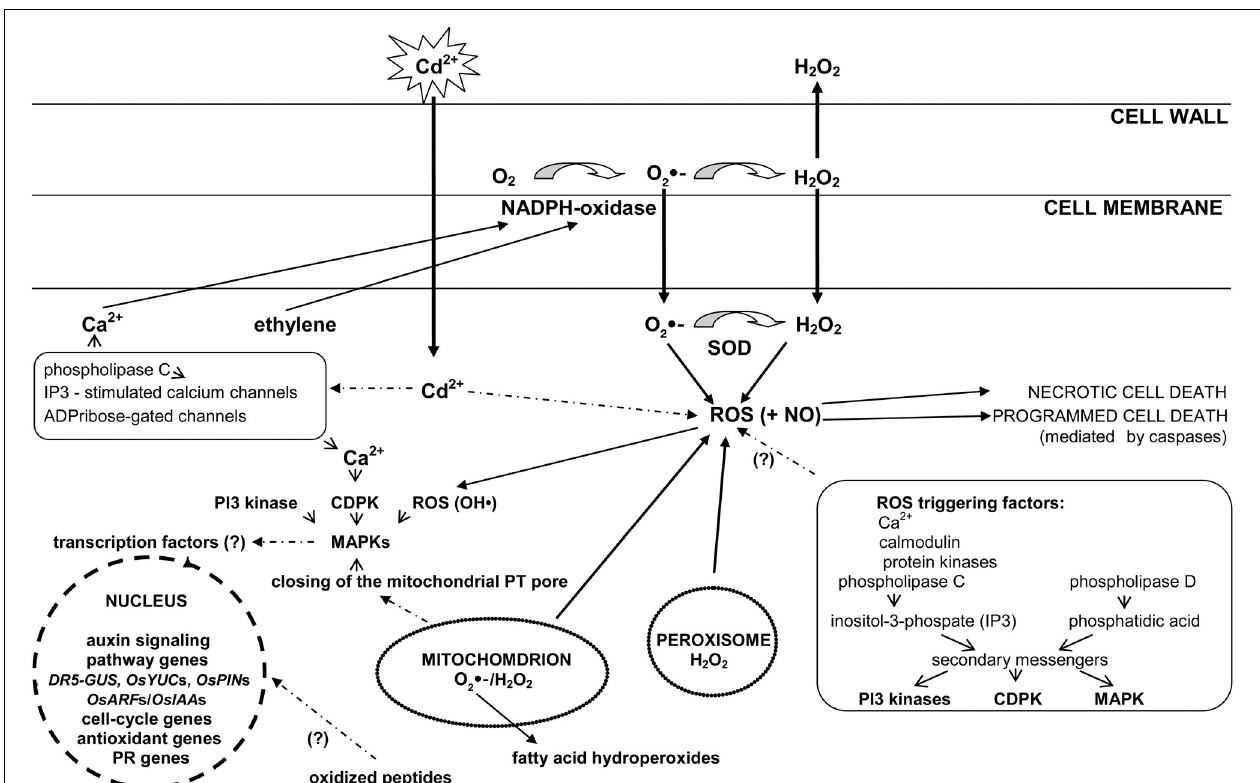
FIGURE 1 | The role of reactive oxygen species in cadmium signal transduction. In response to Cd reactive oxygen species (ROS) can be formed in non-enzymatic and enzymatic reactions (for e.g., catalyzed by NADPH oxidase, superoxide dismutase enzymes) in various cell compartment such as: plasma membrane, mitochondria, or peroxisomes. NADPH oxidase-dependent generation of ROS is regulated by cytosolic free calcium and ethylene. Increase in calcium levels requires phospholipase C activity as well as involves inositol-3-phosphate (IP3)-stimulated calcium channels and ADPribose-gated channels (box on the left). Apart from calcium Cd-induced ROS production is triggered by calmodulin, protein kinases, phospholipase C, and phospholipase D (box on the right). Phospholipases initiate further signaling through increased